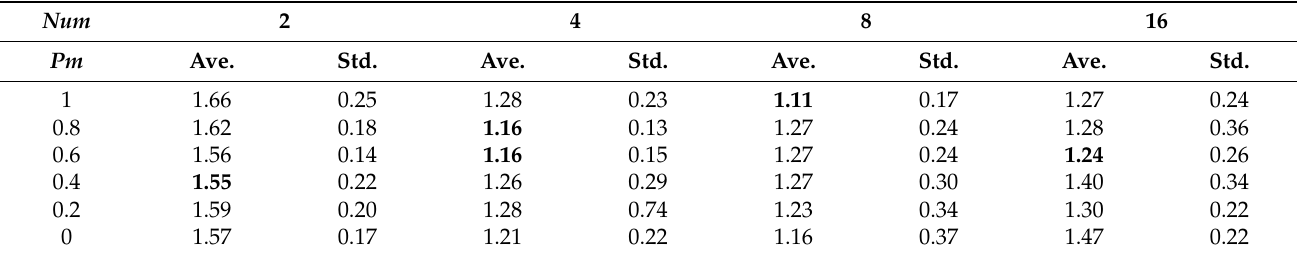
Table 6. Convergence time with different Num and P m in Scenario 1.